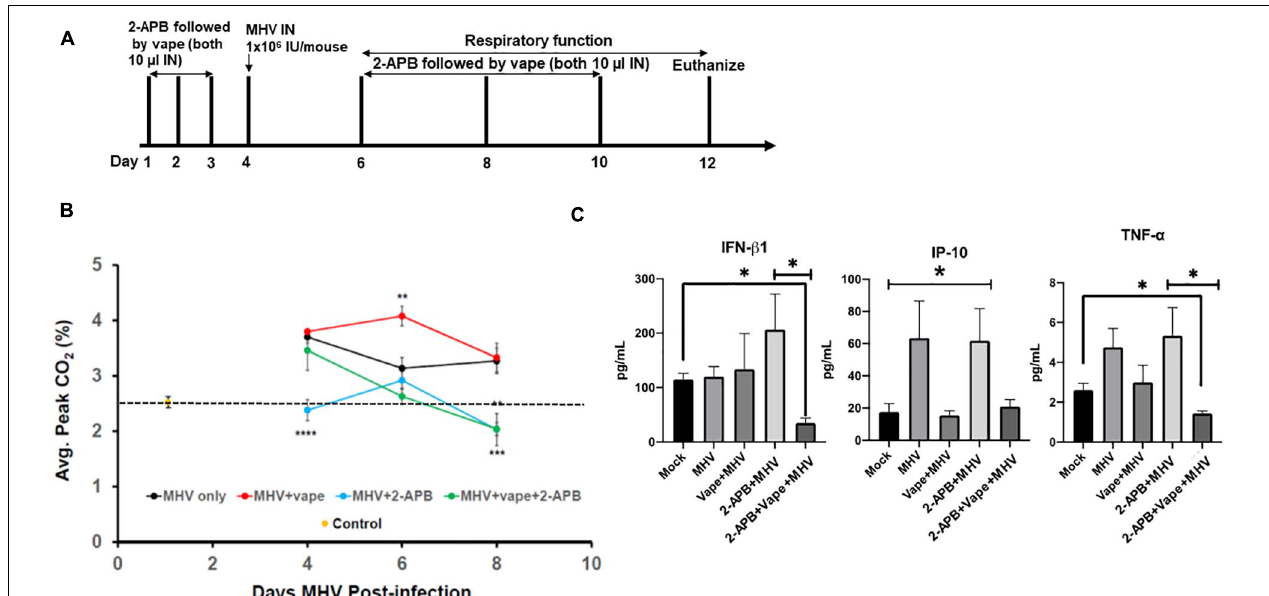
FIGURE 3 | 2-APB treatment reverses some of the effects of MHV infection in mouse lungs. (A) Study design. (B) Average peak CO 2 levels detected from the treatment groups 4, 6, and 8 days PI. The data were acquired using a SomnoSuite low-flow anesthesia system equipped with a nose cone. Mice were sedated with ketamine and monitored for ∼ 2–3 min to acquire peak CO 2 wave forms. N = 6 mice (three males and three females) per group. The dotted line is a reference point for the control. (C) Inflammatory cytokine analysis of BAL fluid from mice infected with MHV, vape + MHV, 2-APB + MHV, and 2-APB + vape + MHV (compared with mock control). ANOVA was performed for multigroup comparisons (Tukey’s multiple comparison tests). The statistically significant IP-10 comparisons (* P < 0.05) are made between the mock and MHV groups, and the mock and 2-APB + MHV groups only. Symbols and bars represent the mean ± SEM compared with the